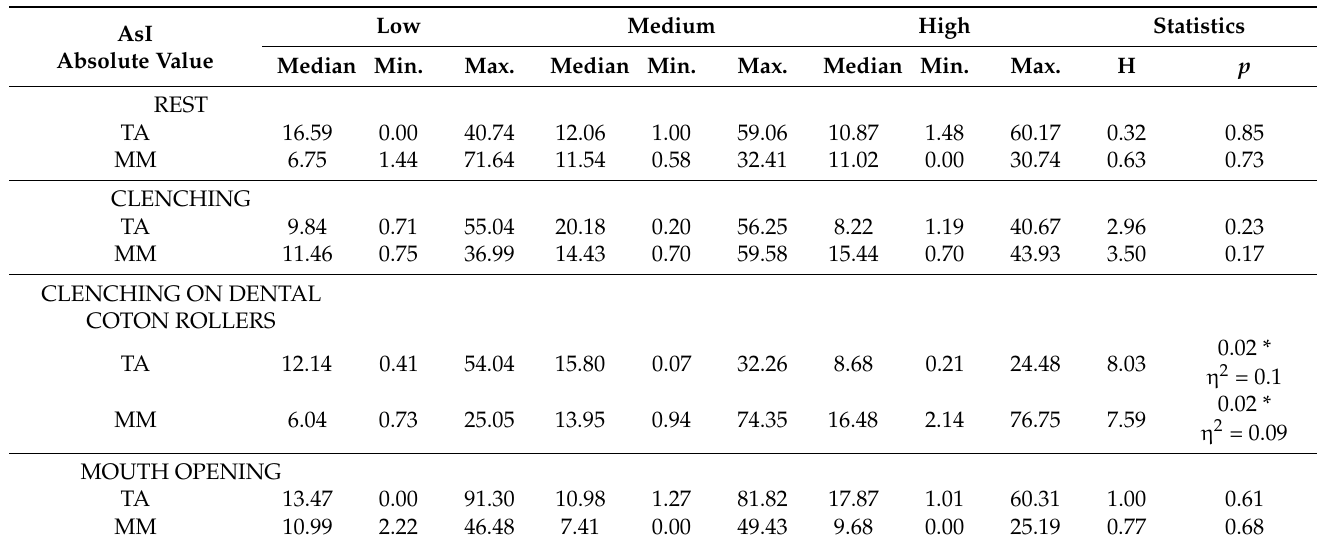
Table 3. The absolute values of asymmetry index (AsI) in studied groups.